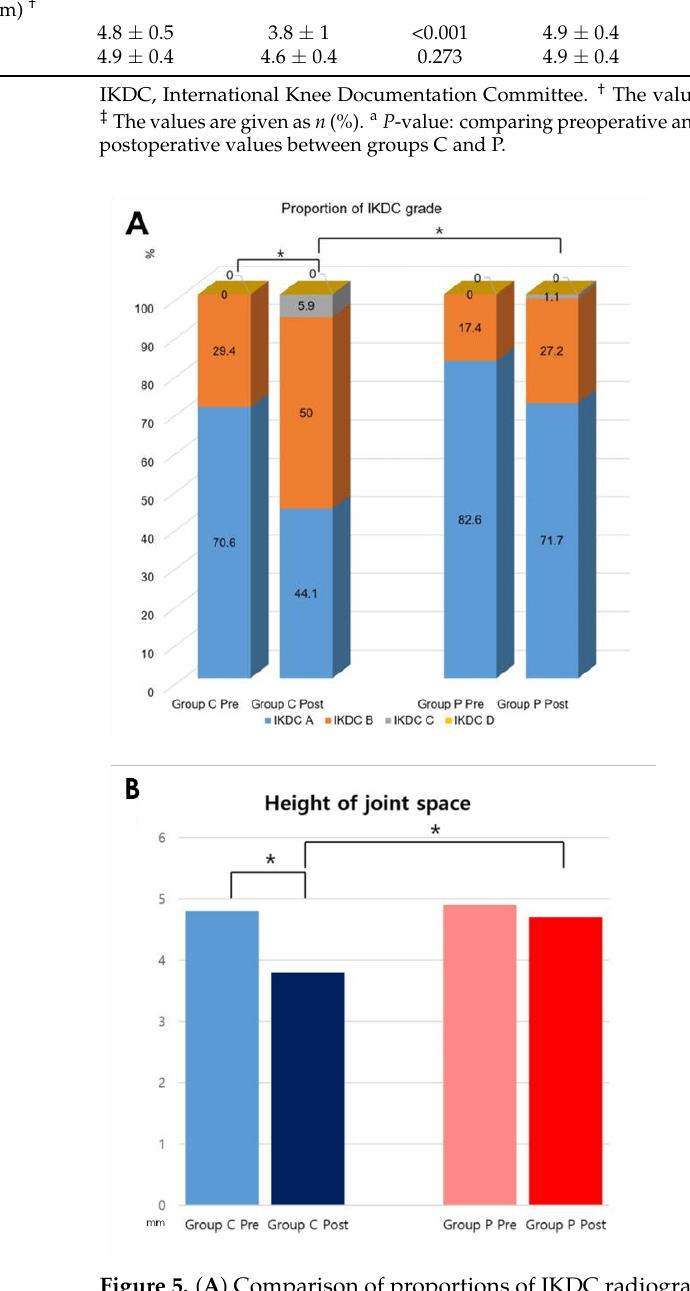
Figure 5. ( A ) Comparison of proportions of IKDC radiographic scale for preoperative and postop- erative values within groups and postoperative values between the groups. ( B ) Comparison of the heights of the joint space at the affected side for preoperative and postoperative values within groups and postoperative values between groups. Pre, preoperative; Post, postoperative. * p < 0.05.